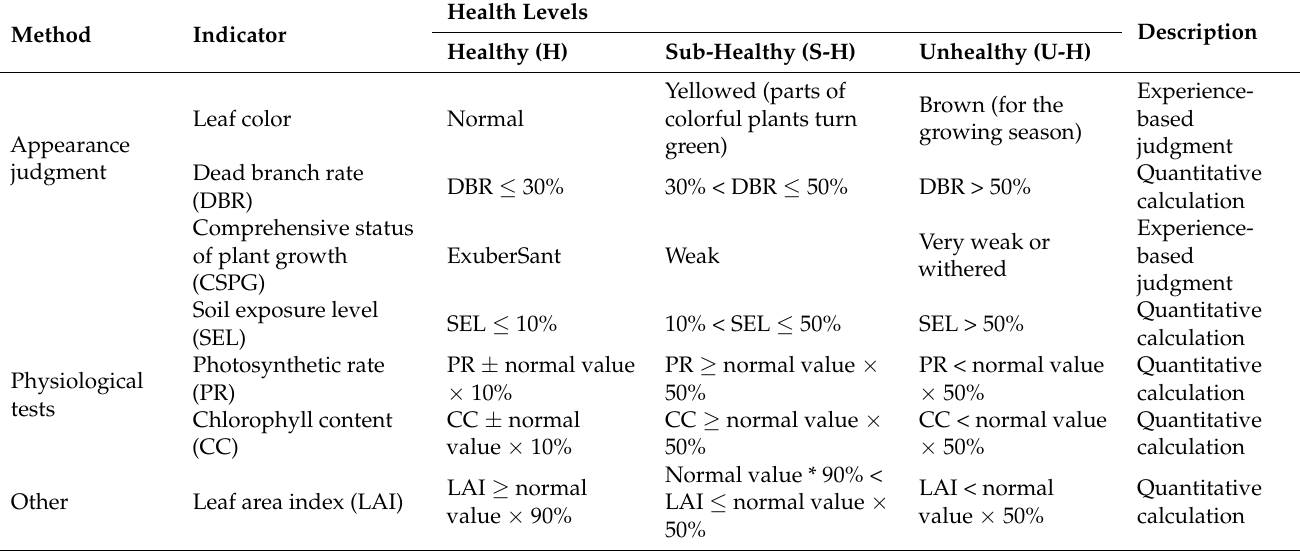
Table 2. Health standard system used to determine the state of plant